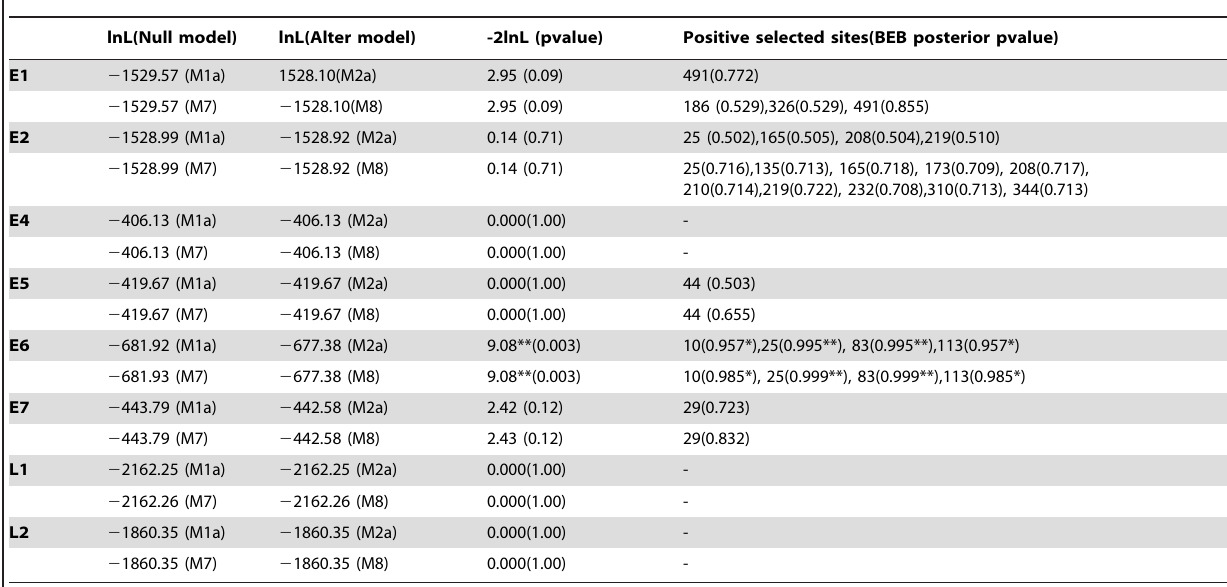
Table 2. Likelihood ratio test for the eight genes across the HPV genome